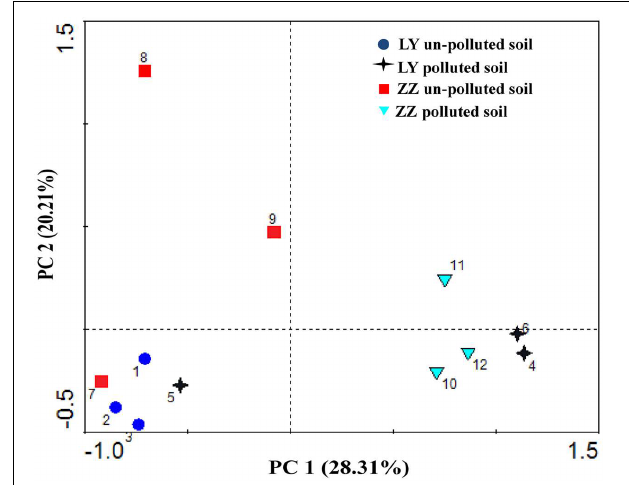
FIGURE 3 | Principal component analysis (PCA) for functional diversity of microbial communities in soil collected from different areas.